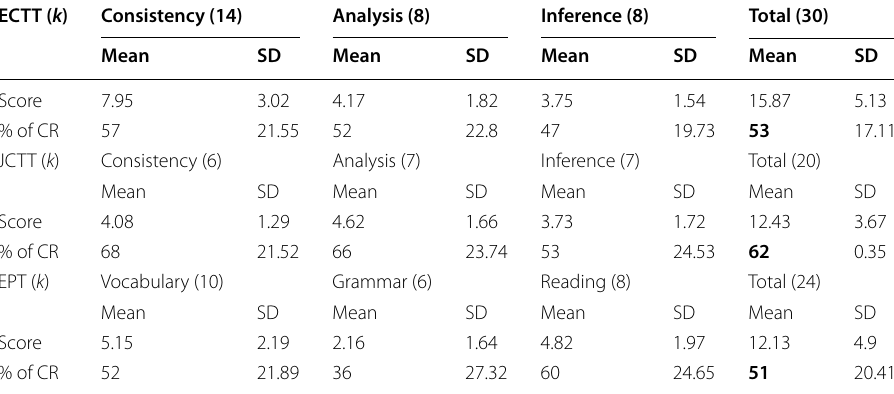
Table 4 Descriptive statistics of ECTT, JCTT, and